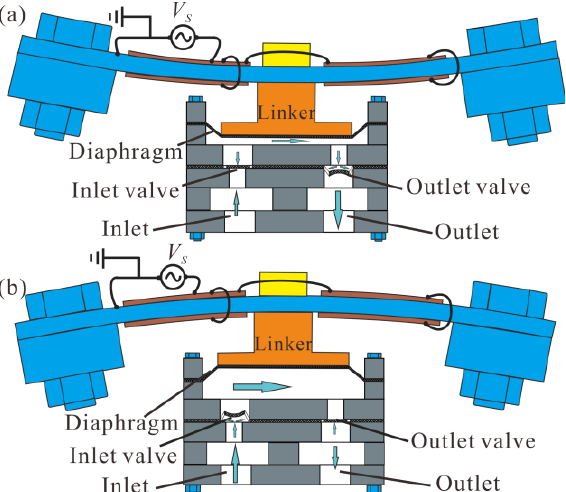
Figure 9. Working principle of the piezoelectric pump: ( a ) dispensing mode, and ( b ) absorbing